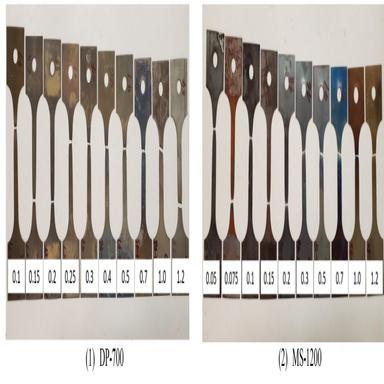
Failure modes of specimens in transient-state tests.